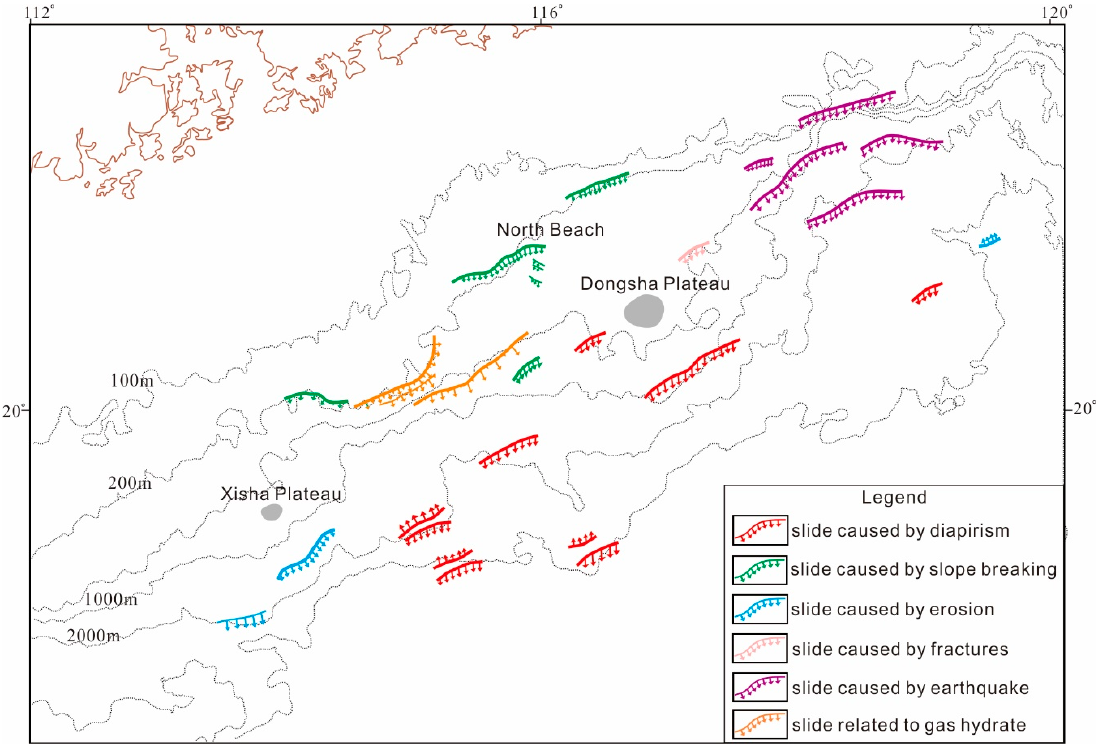
Figure 12. Distribution of different types of landslides in gas hydrate deposit area in the northern slope of South China Sea.